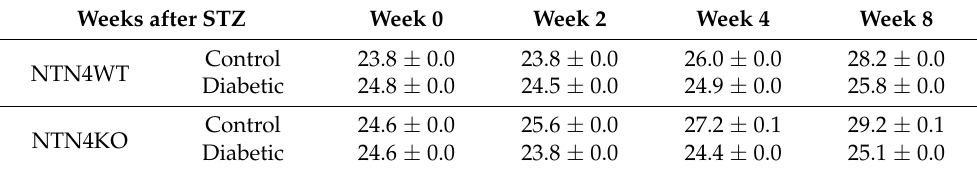
Table 2. Weight after diabetes induction 1